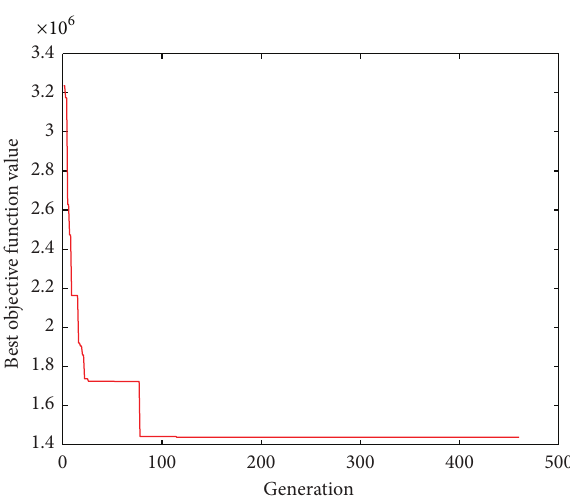
Figure 7: Topological structure of the network.